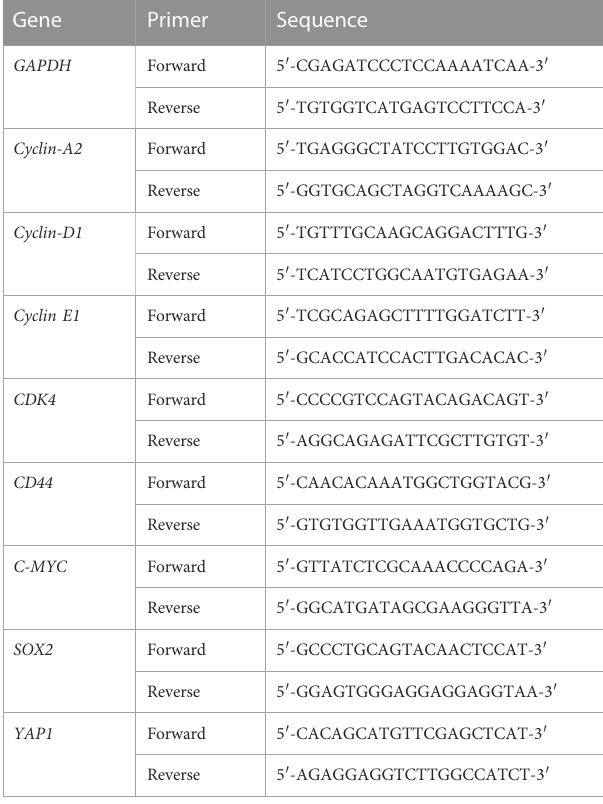
TABLE 2 Primers for real-time quantitative PCR analysis of